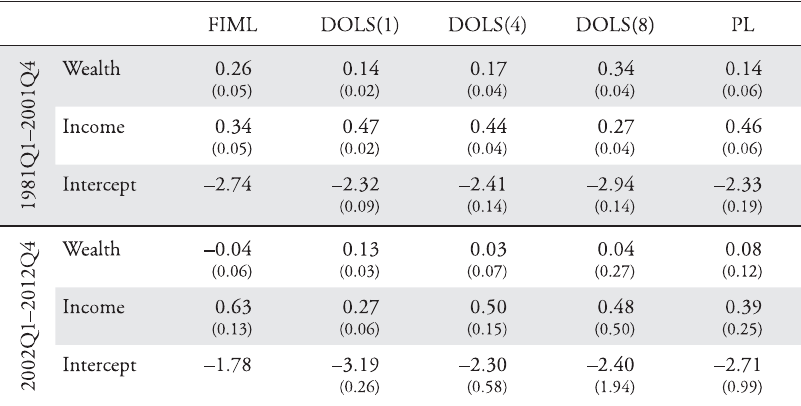
Table 4: Estimation of the Cointegrating Vector: Different Time Spans FIML DOLS(l) DOLS(4) DOLS(B) PL § Wealth 0.26